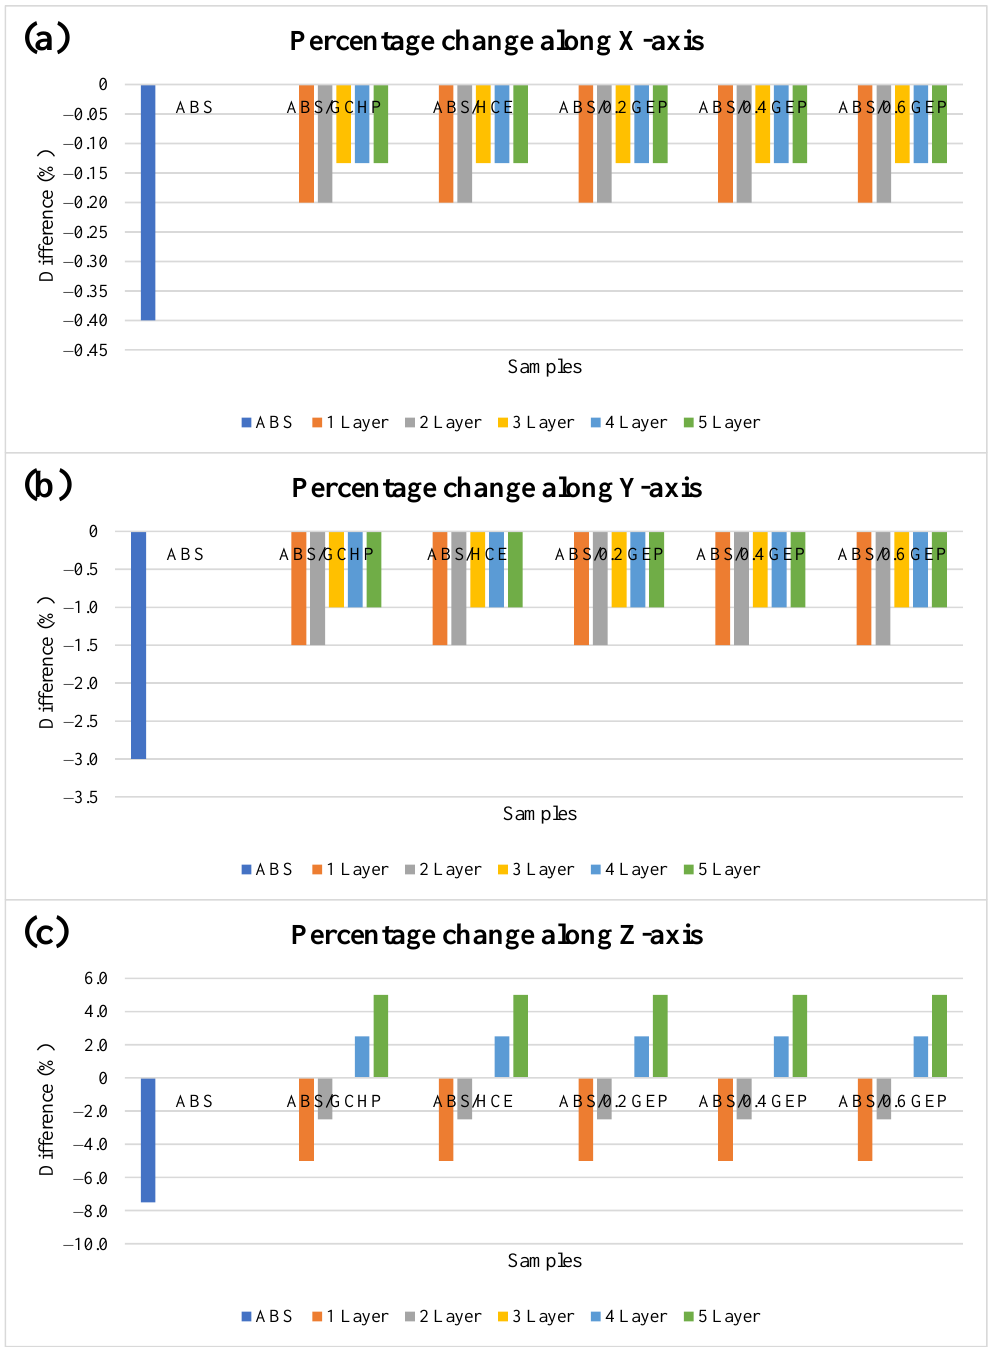
Figure 5. Dimensional analysis: ( a ) percentage change along X -axis; ( b ) percentage change along Y -axis; ( c ) percentage change along Z -axis.